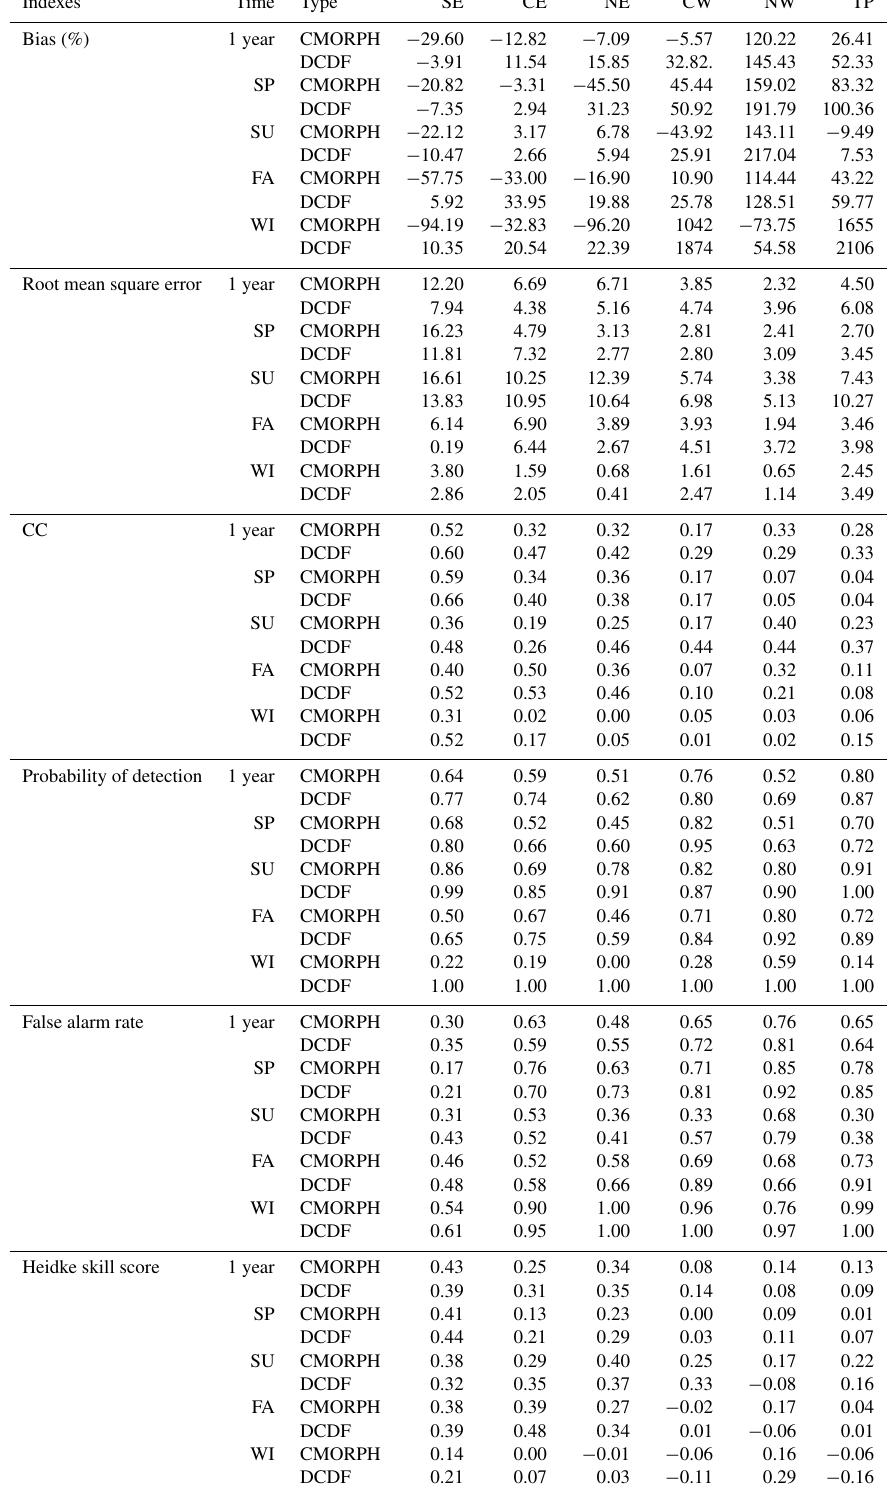
Table 2. Validation results of the daily precipitation for CMORPH and DCDF in 2014 in the six study